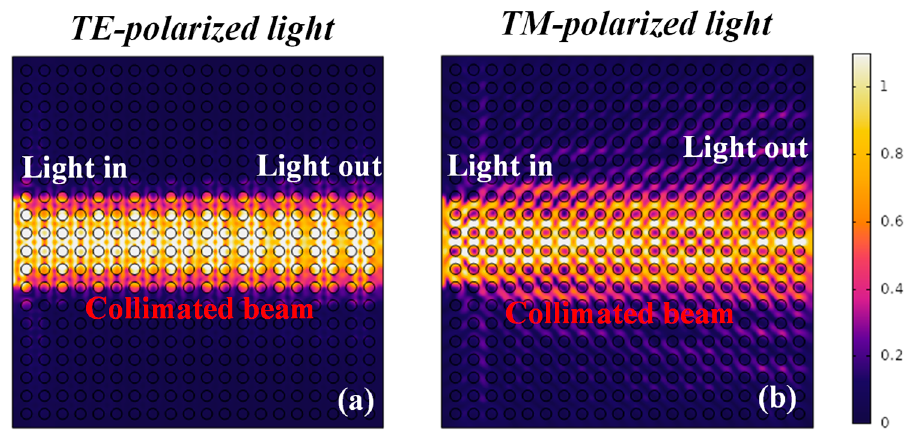
Figure 2. Norm. electric field distribution at λ = 1550 nm at ( a ) TE-polarization of light, ( b ) TM- polarization of light.